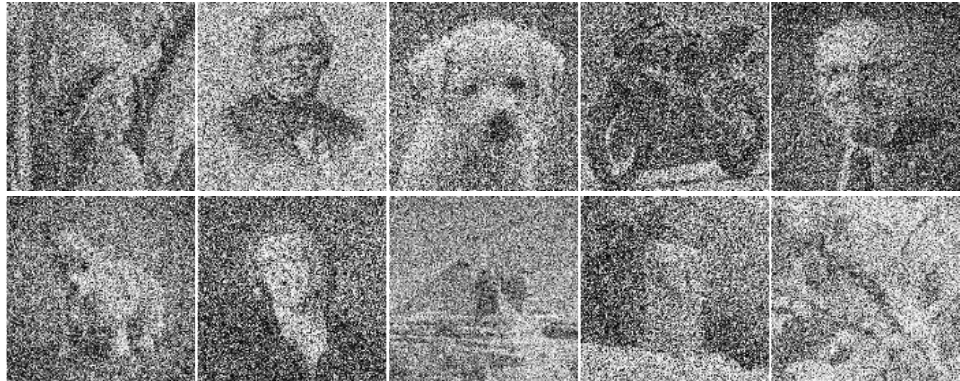
Figure 6. The 10 grayscale images with Gaussian noise at the SNR of − 10 dB. The Gaussian noise was added to the input images with the SNR varied from − 10 to 4 dB. The original images were stored in the crossbar array, as conceptually explained above. The images with noise added were then digitized by 4 bits and applied to the complementary crossbar array, the twin crossbar array, and the single crossbar array for recognition. Figure 7a shows the comparison of recognition rates among the three crossbar architectures where the SNR was varied form − 10 to 4